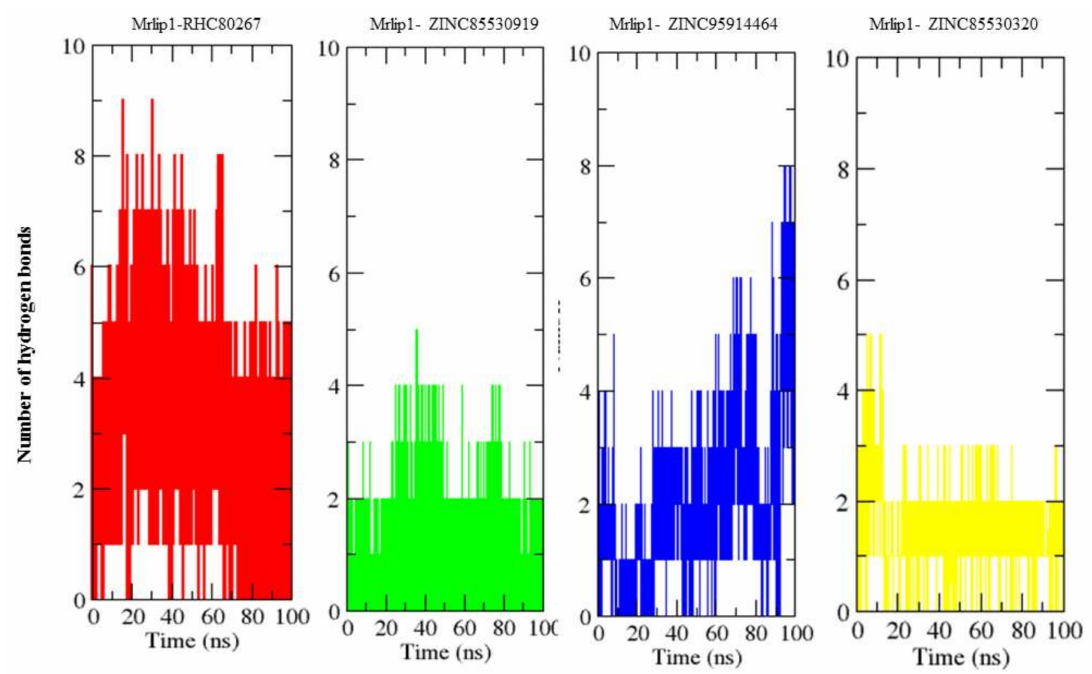
Figure 7. Hydrogen bonds analysis. The average number of hydrogen bonds between Mrlip1- RHC80267, Mrlip1-ZINC85530919, Mrlip1-ZINC95914464, and Mrlip1-ZINC85530320 as a function of time. The values were presented during 100,000 ps (100 ns) MD simulations time scale. The red, green, blue, and yellow color represent values obtained for Mrlip1-RHC80267, Mrlip1-ZINC85530919, Mrlip1-ZINC95914464, and Mrlip1-ZINC85530320 complexes respectively.